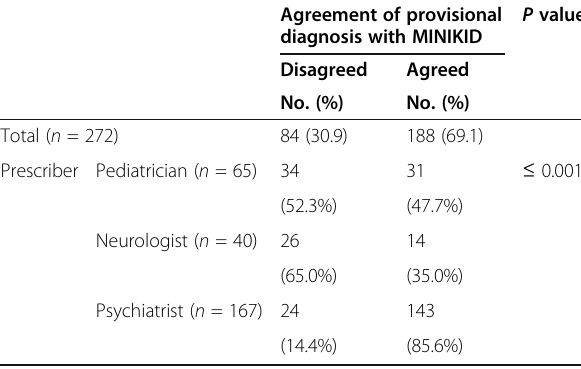
Table 5 Agreement of provisional diagnosis with MINIKID for each prescriber specialty Agreement of provisional diagnosis with MINIKID